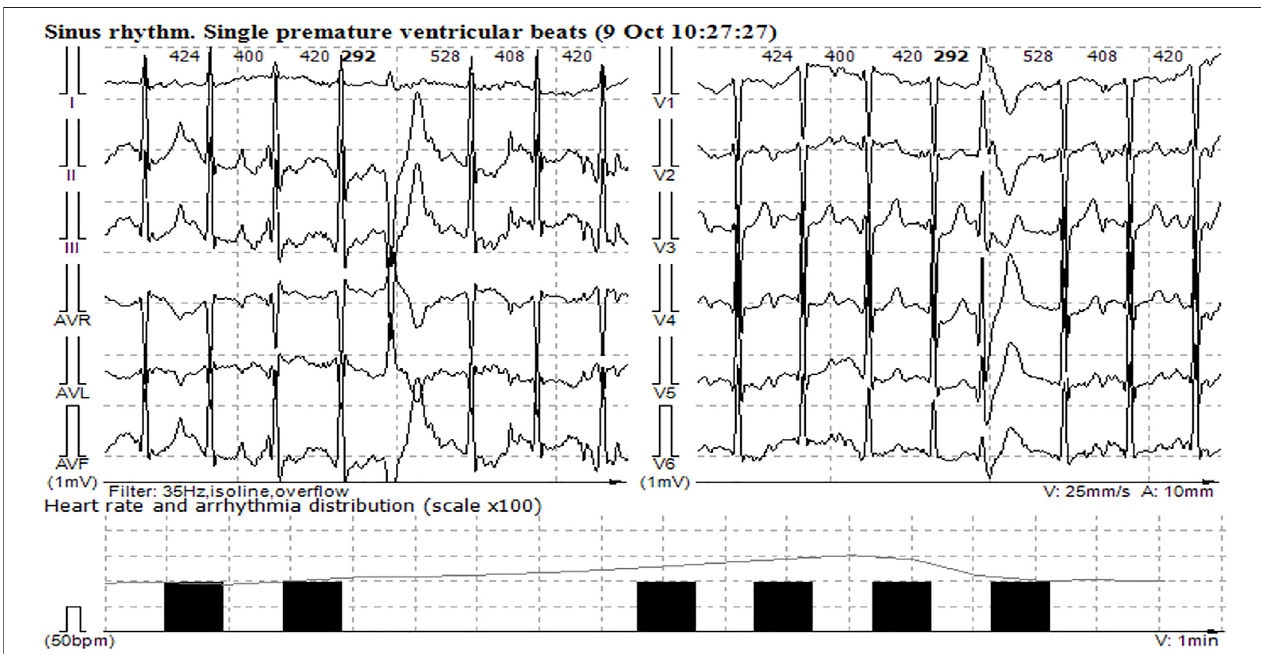
FIGURE 3 | Single monomorphic ventricular ectopic complexes during and at the peak of stress echocardiography.